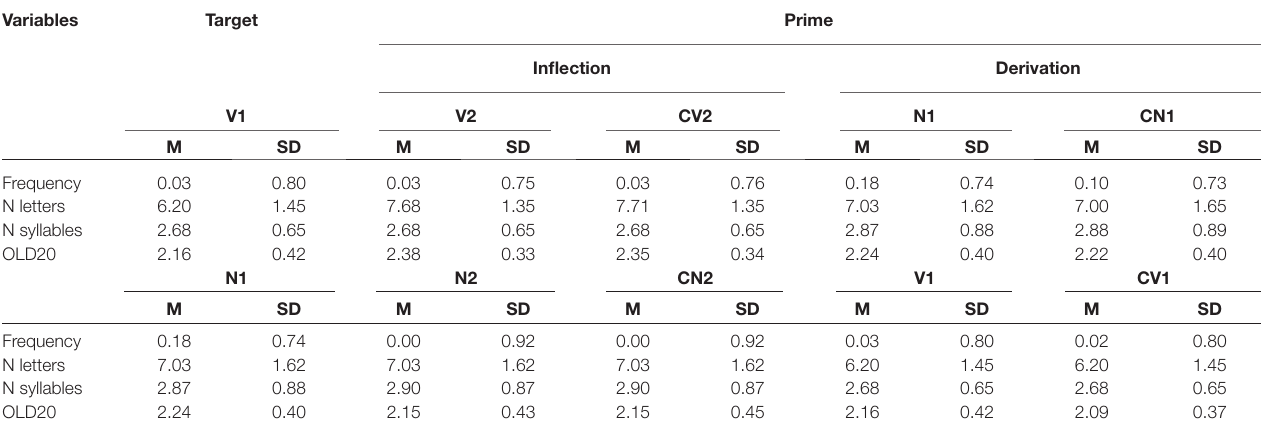
TABLE 3 | Stimulus variables for primes and targets of Experiments 1–4. Variables